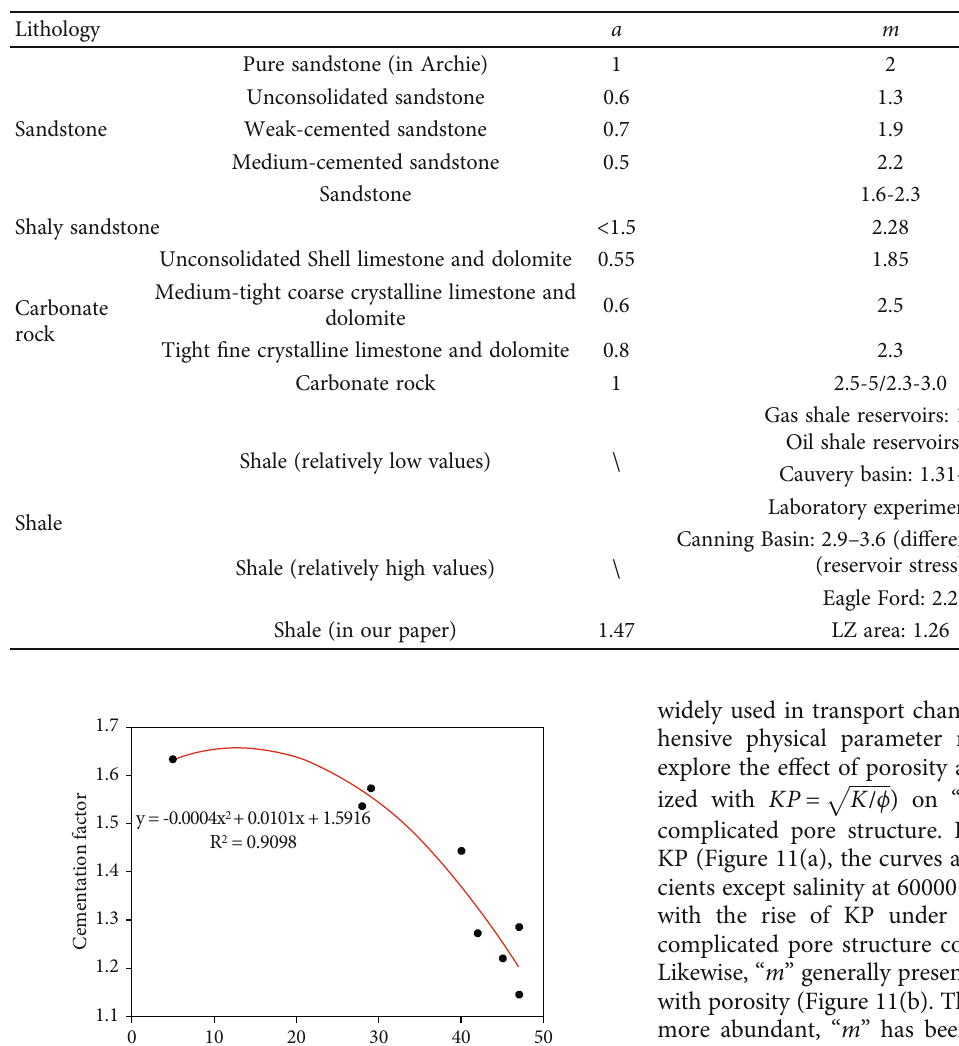
Table 3: Comparative analysis results of Archie ’ s parameters in di ff erent rocks [1, 3, 7, 26, 37, 49 – 59].